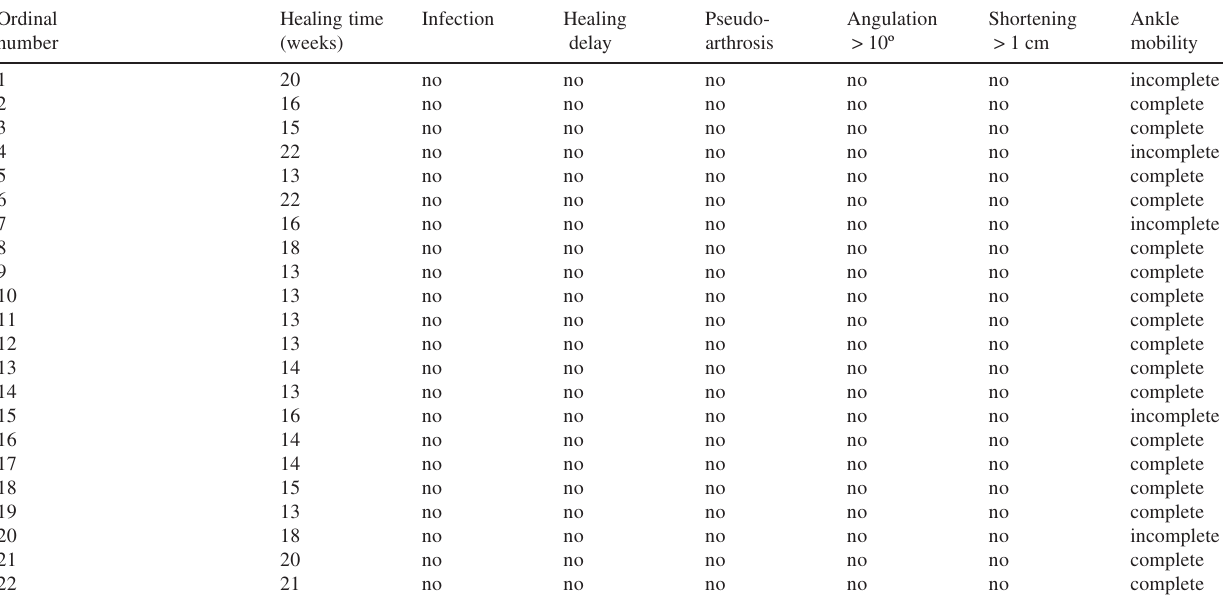
Table 4 - Individual results for patients undergoing a surgical treatment with bridging plates: ordinal number, healing time, infection, healing delay, pseudoarthrosis, angulation, shortening, and ankle mobility Ordinal